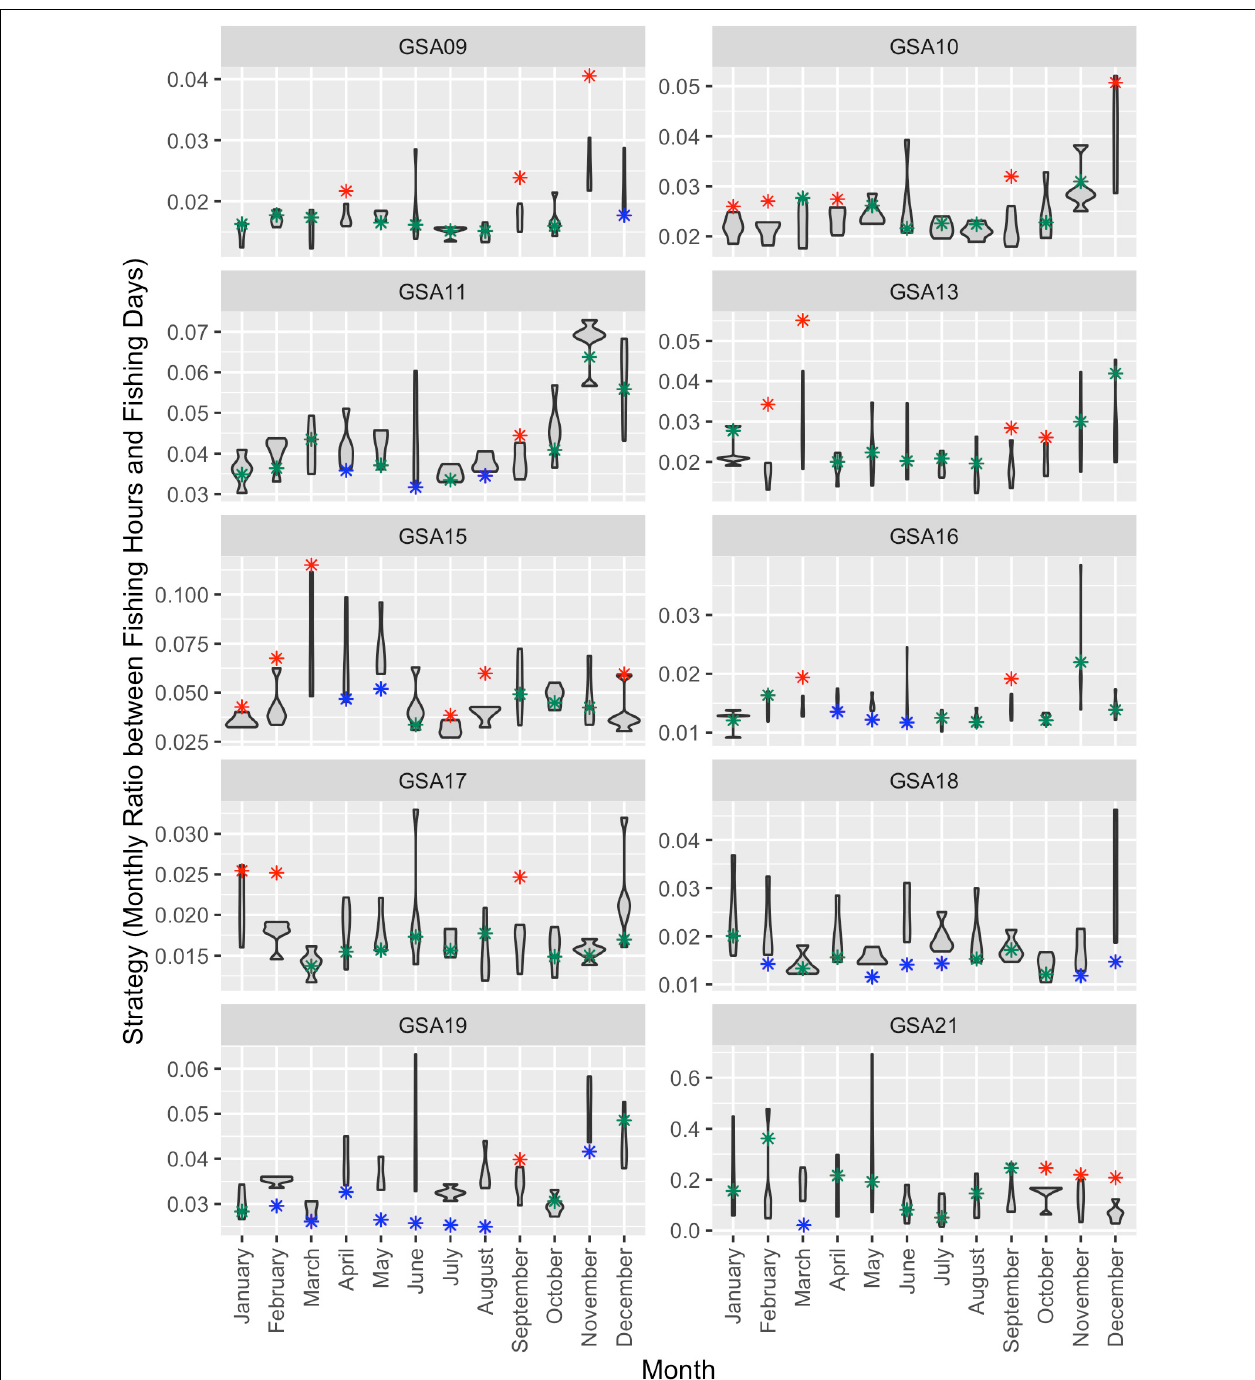
FIGURE 4 | Violin plot of the values of Strategy by month and GSA. The values of the years 2015–2019 are represented by the violin, while those of the year 2020 (during the pandemic) are represented as asterisks colored in red when significantly higher than those in the reference period, in blue when significantly lower than those in the reference period and in green when coherent with those in the reference